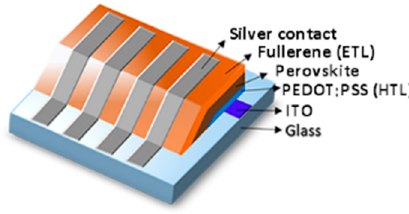
Figure 1. Inverted planar perovskite solar cell (PSC) representation with the structure of indium tin oxide (ITO)/poly(3,4-ethylenedioxythiophene)-polystyrene sulfonate (PEDOT:PSS)/perovskite/electron-transport layer (ETL)/silver.